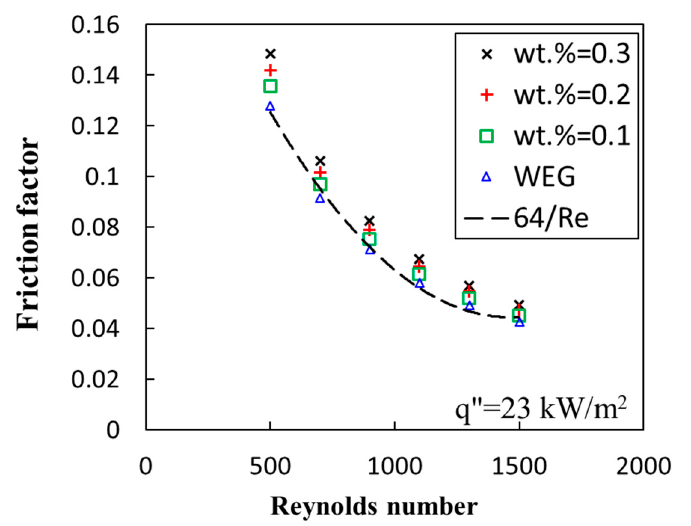
Figure 7. Variation of the friction factor with Reynolds number for WEG and nanofluids.